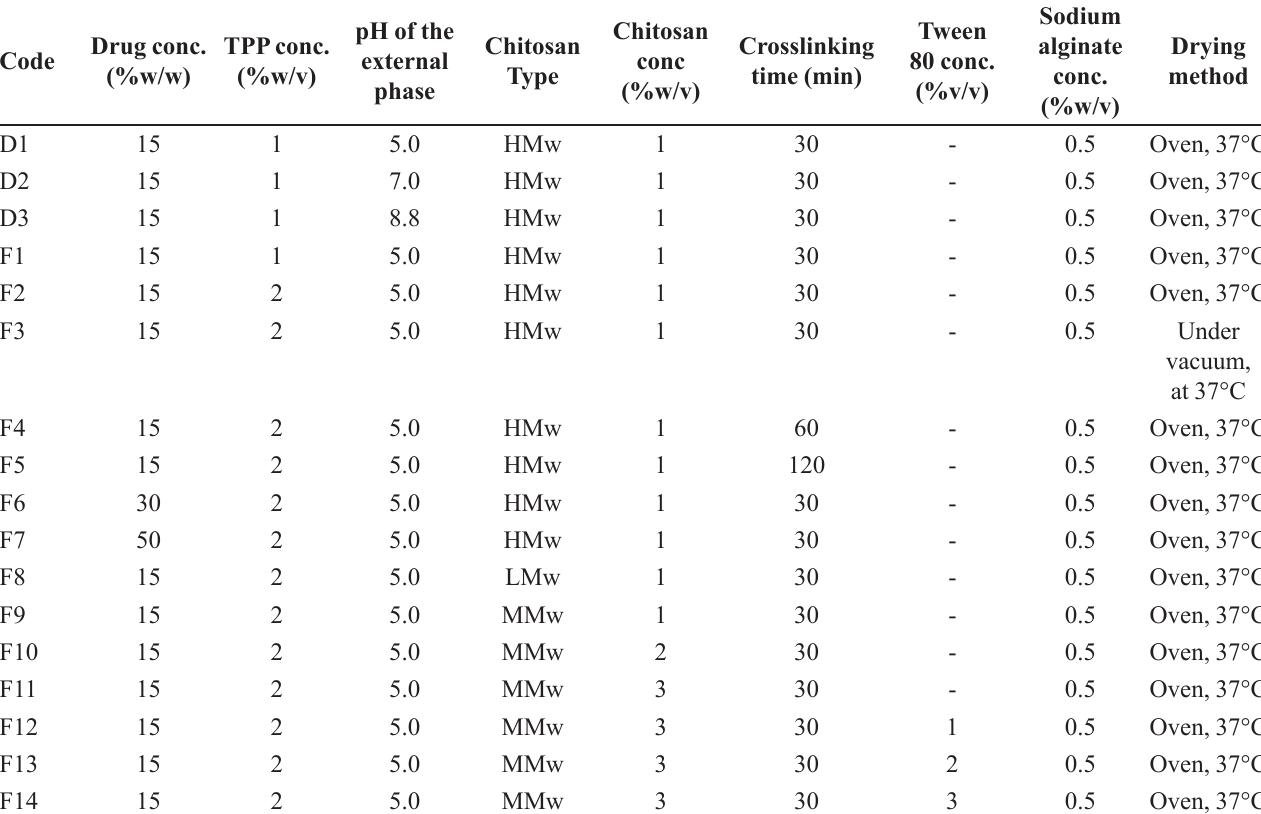
TABLE II - The formulations used in the study